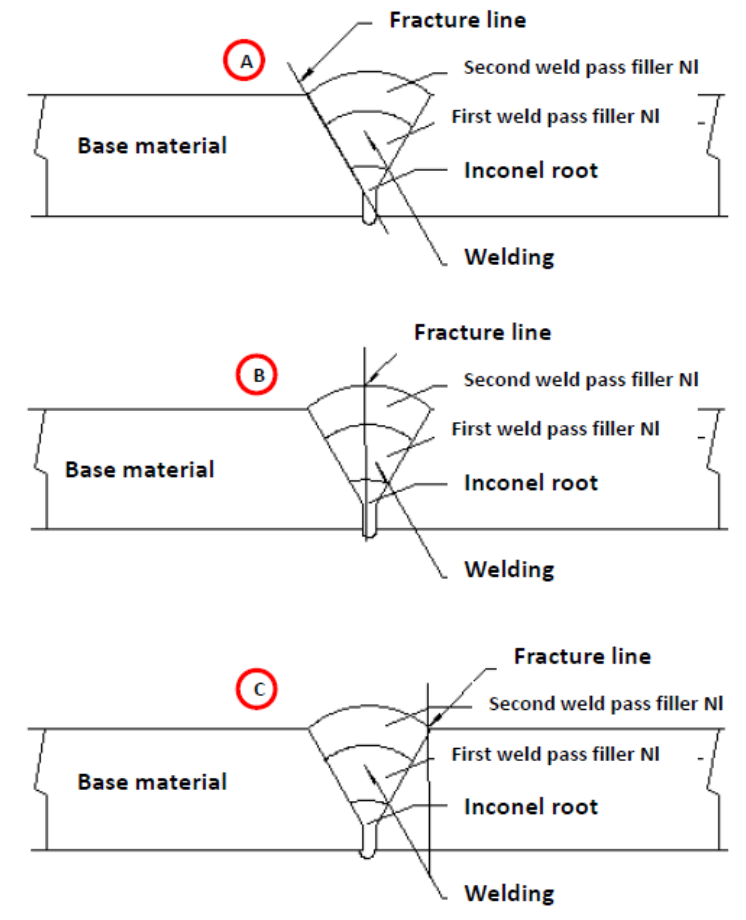
Figure 9. Zones of metallographic observation: ( A ) weld base metal base interface, ( B ) weld bead, ( C ) base metal.